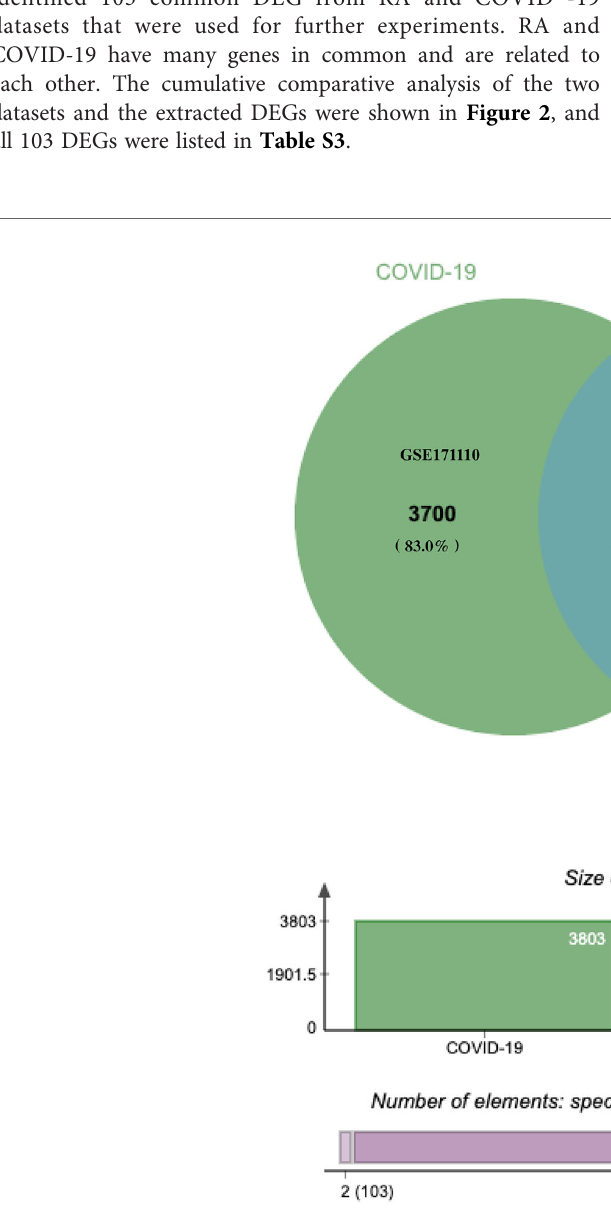
FIGURE 2 | The study included a microarray and an RNA-seq dataset, RA (GSE17755) and COVID-19 (GSE171110). A comprehensive analysis showed that there were 103 common DEGs between COVID-19 and